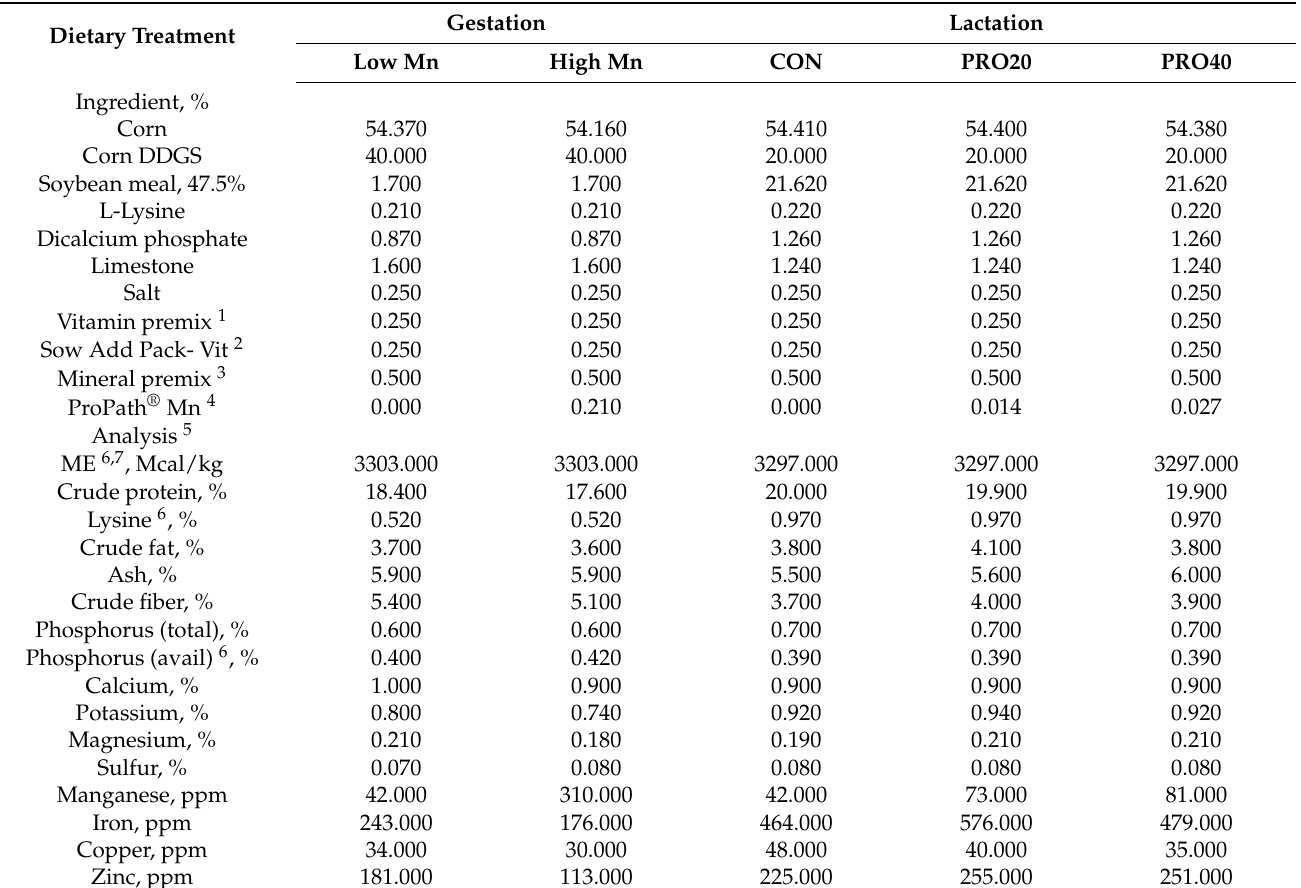
Table 1. Dietary composition and analysis on an as-fed